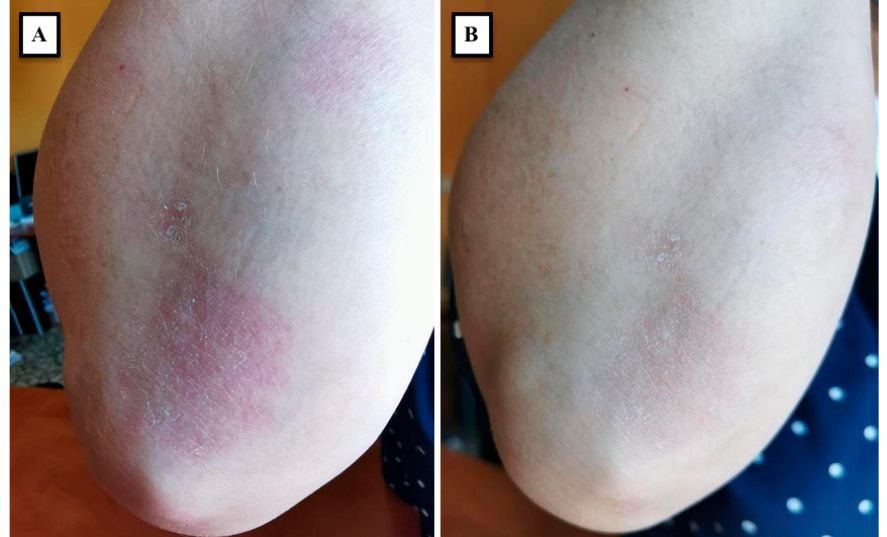
Figure 1. Psoriasis plaques on the extensor surfaces of the elbow and forearm before ( A ) and 1 month after ( B ) a single injection session with 1000 U of abobotulinumtoxinA for treating upper-limb spas- ticity.